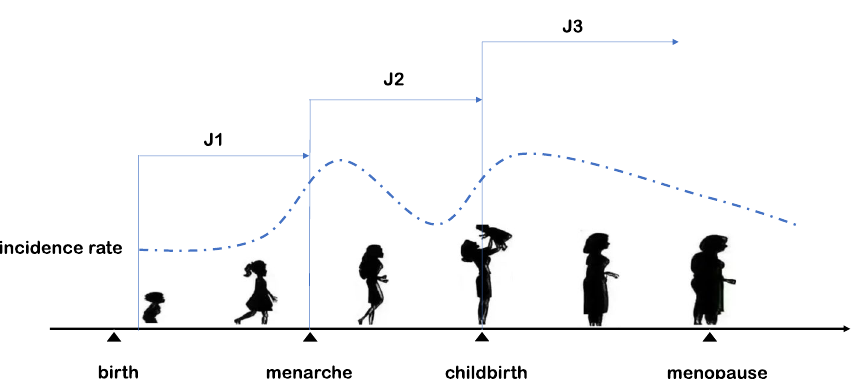
Fig. 1 Schematic diagrame of patients grouping. The patients were grouped according to the association of migraine onset with menarche and childbirth. Patients were divided into three groups: migraine onset before menarche (group J1), onset between menarche and childbirth (group J2) and onset after childbirth (group J3). The expected incidence rate is symbolically sketched by a dotted